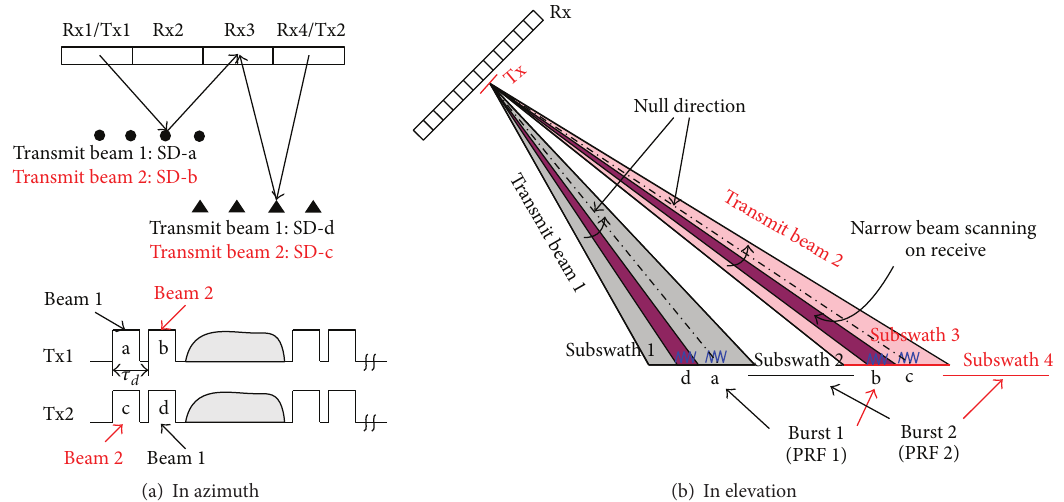
Figure 1: Beamspace MIMO-SAR imaging scheme. (a) Four subpulses are transmitted by two subapertures in a single PRI, which results in more spatial diversities (SDs) in azimuth. (b) Two subpulses transmitted by the same Tx are used to illuminate different subswaths, while echoes corresponding to subpulses with different time delays transmitted by different subapertures are separated by narrow beam scanning on receive with null steering.